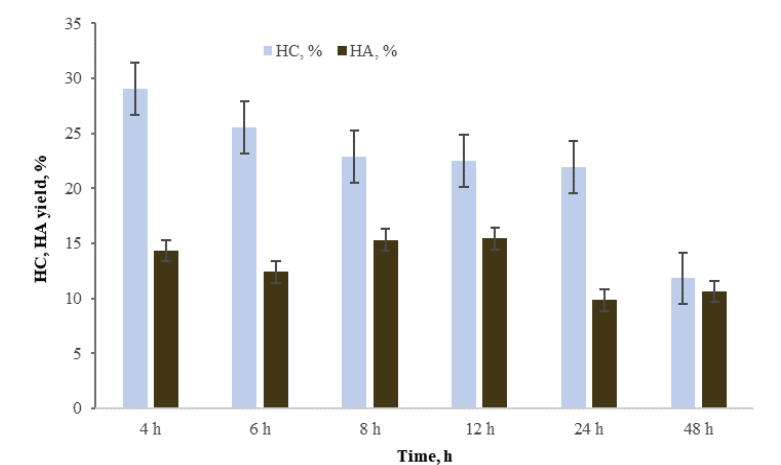
Fig. 3. Effect of time on the yield of humic acids and hydrochar as a result of hydrothermal carbonisation of wheat straw